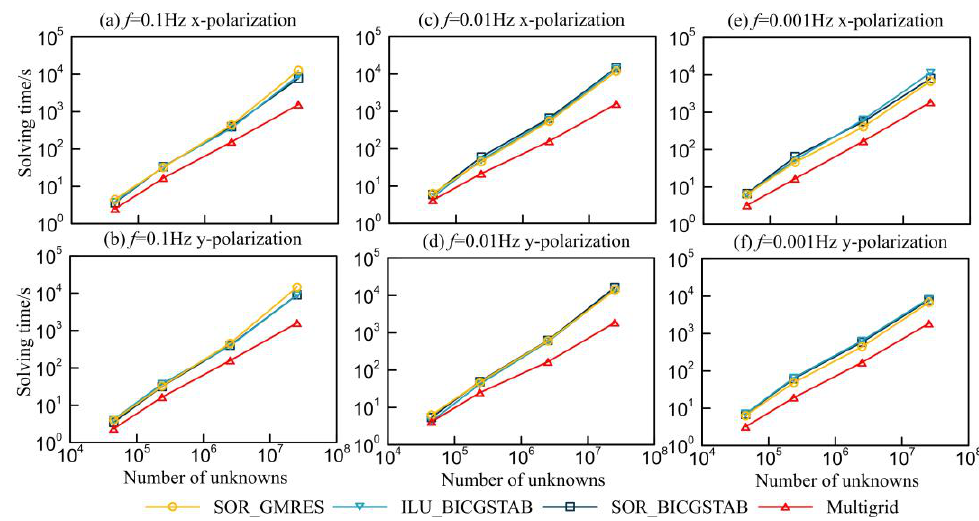
Figure 13 . Comparison of computational time for SOR-GMRES, ILU-BICGSTAB, SOR-BICGSTAB and our MG algorithm for DTM1 model in x , y -polarization modes at 0.1, 0.01 and 0.001 Hz. The residual threshold is set to 10 −7 . The computation is conducted on the grids of 24 × 24 × 24, 48 × 48 × 33, 128 × 128 × 50, 256 × 256 × 128, with the DoFs of 45,000, 2,391,69, 2,516,274, 25,428,608.